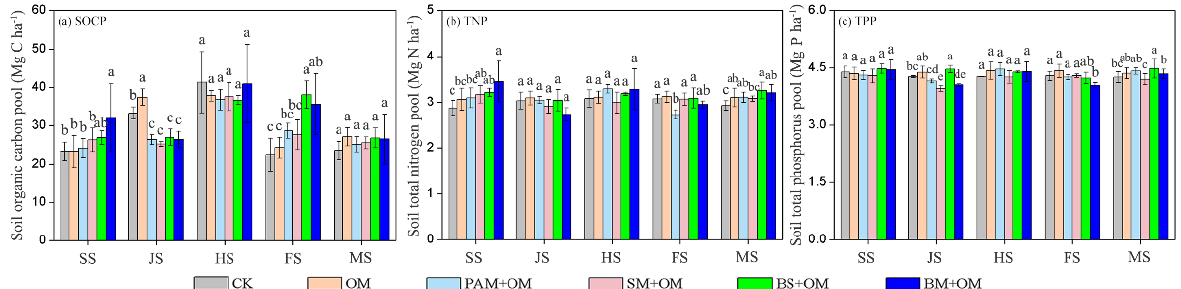
Figure 3. Dynamics of SOCP ( a ), TNP ( b ), and TPP ( c ) under different oat growth stages in 0–40 cm. SOCP: soil organic carbon; TNP: total nitrogen; TPP: total phosphorus pools; SS: seedling stage; JS: jointing stage; HS: heading stage; FS: filling stage; MS: maturation stage. Values are means of three replicates ± SD; error bars refer to standard deviation; values having different lowercase letters on the bars indicate significant differences among different treatments (LSD, p < 0.05).